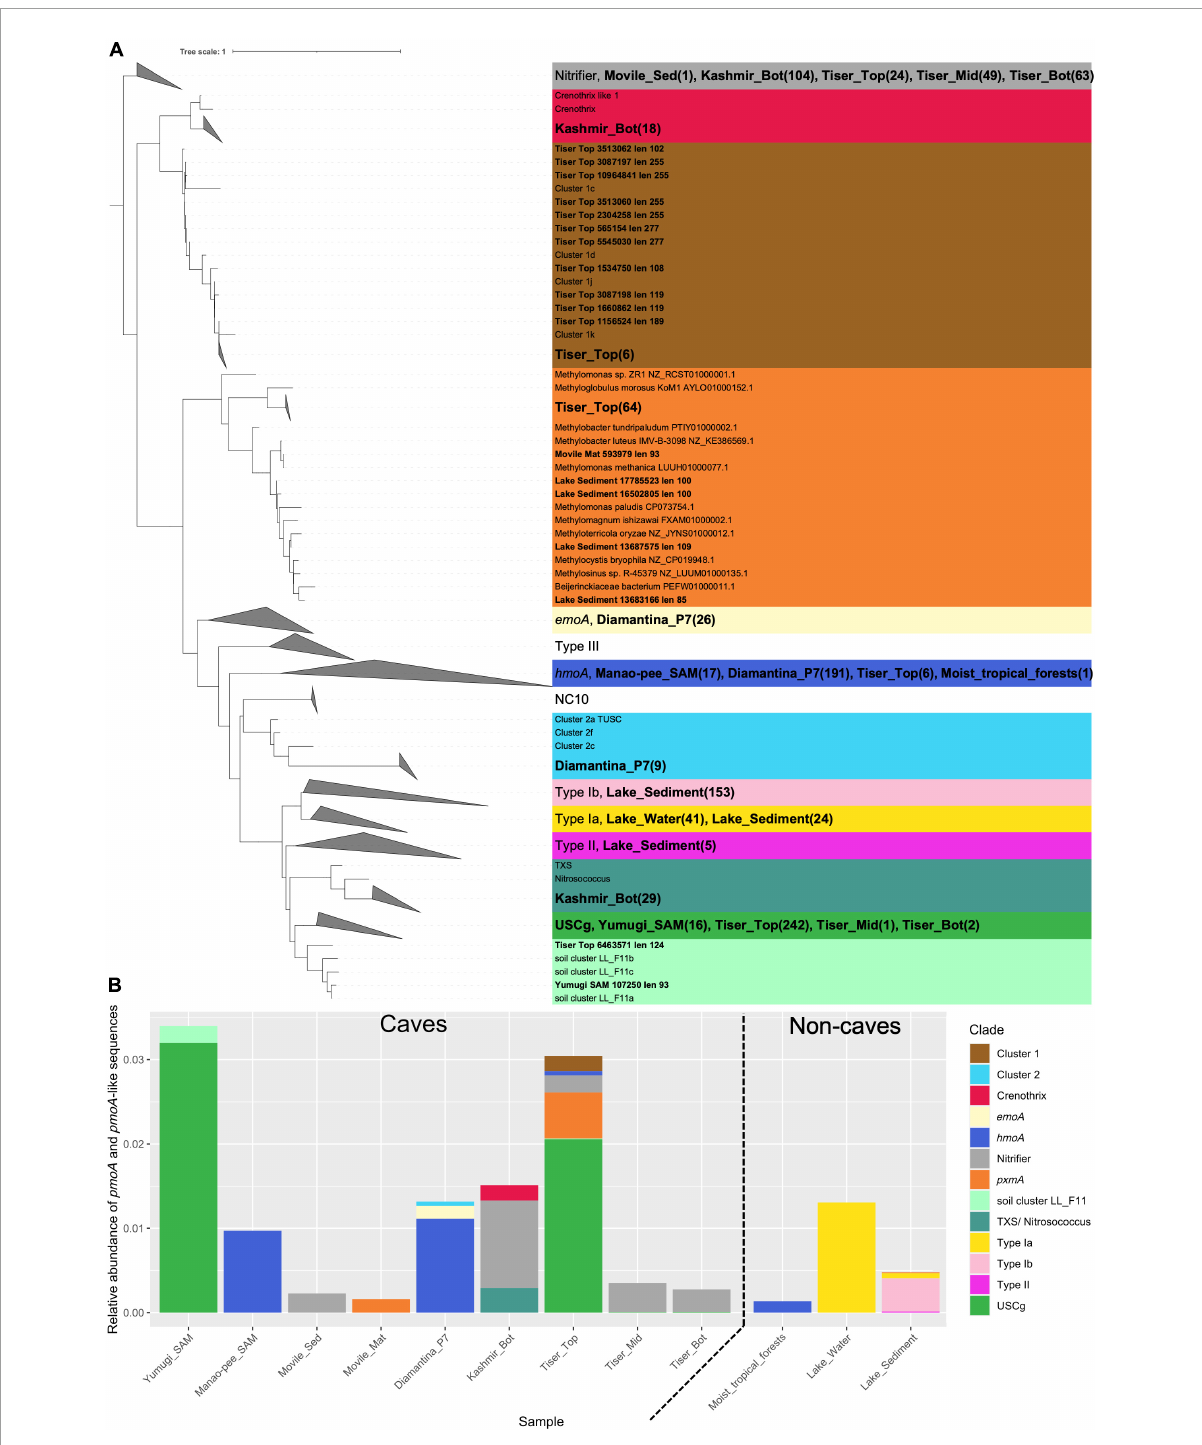
FIGURE3 A maximum-likelihood phylogenetic tree of pmoA and pmoA -like protein sequences retrieved from CEPD (A) and relative abundance of different clusters in cave metagenomes (B) . Protein sequences from the metagenome samples were assembled by PLASS and concatenated to form a single cave protein catalog which was searched using HMMER3. Metagenome hits were aligned to protein reference sequences from Knief (2015) using Clustal Omega. Conserved regions in these alignments were identified using trimAl followed by phylogenetic reconstruction of multiple sequence alignment using IQTree. (A) Cave sequence labels are bolded. Sequences are colored according to their assigned cluster based on clusters listed in Knief (2015). Clades containing 3 or more cave sequences and no reference sequences were collapsed, node labels show the breakdown of hits by metagenome in brackets (B) The number of sequences retrieved was normalized against the mean number of hits the single copy marker genes gyrB , recB , and rpoB in each